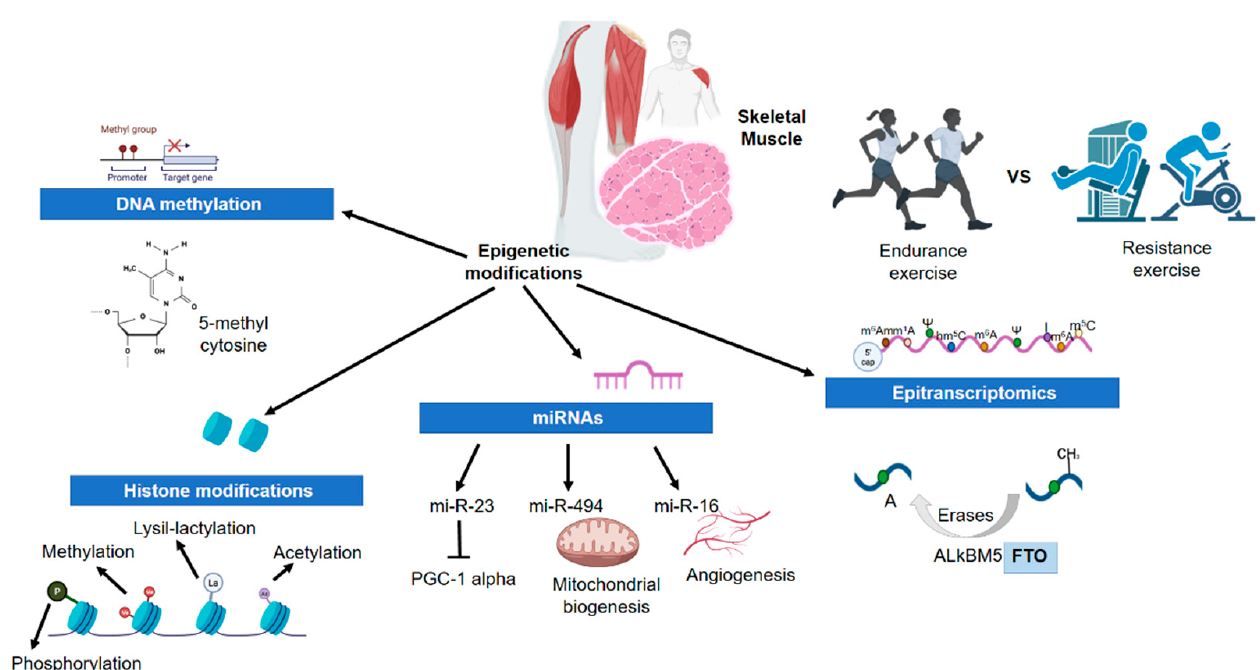
Figure 1. Effects of exercise on epigenetic modifications in skeletal muscle. Abbreviations: FTO, al- pha-Ketoglutarate dependent dioxygenase; PGC-1 alpha, Peroxisome Proliferator-Activated Recep- tor Gamma Coactivator 1 Alpha.